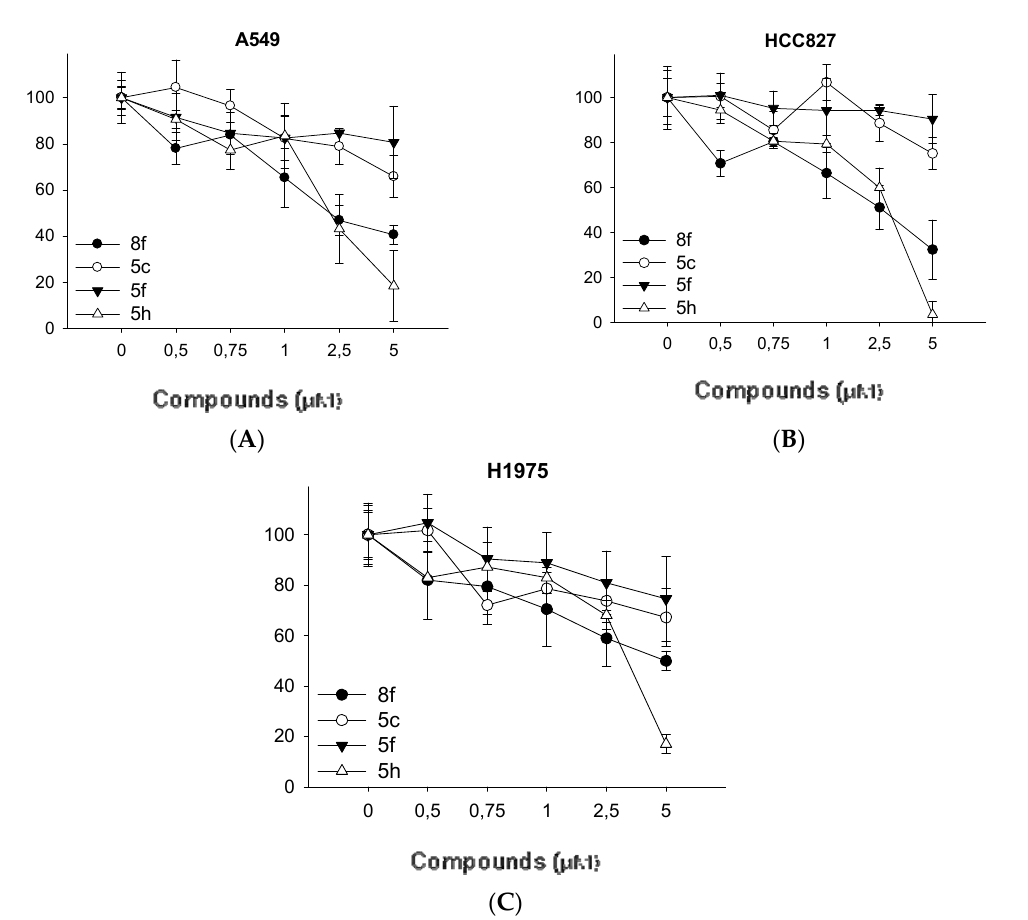
Figure 1. The compounds 5c , 5f , 5h , and 8f are able to reduce cell density of cultured NSCLC cell lines. Percent of cell density of A549 ( A ), HCC827 ( B ), and H1975 ( C ) NSCLC cells treated with different doses (0.5–5 µM) of the compounds 5c , 5f , 5h , and 8f for 3 days, as measured by 3-(4,5-dimethylthiazol-2-yl)-2,5-diphenyltetrazolium bromide (MTT) assay. Data represent the mean (±SD) of three independent experiments, each performed in triplicate. Bars show SDs. Statistical significance was determined by the Student t -test: p < 0.1 for compounds 5c (5 µM, A549), 5h (2.5 µM, all cell lines), and 8f (2.5 µM, all cell lines); p < 0.01 for compounds 5h (5 µM, all cell lines) and 8f (5 µM, all cell lines).